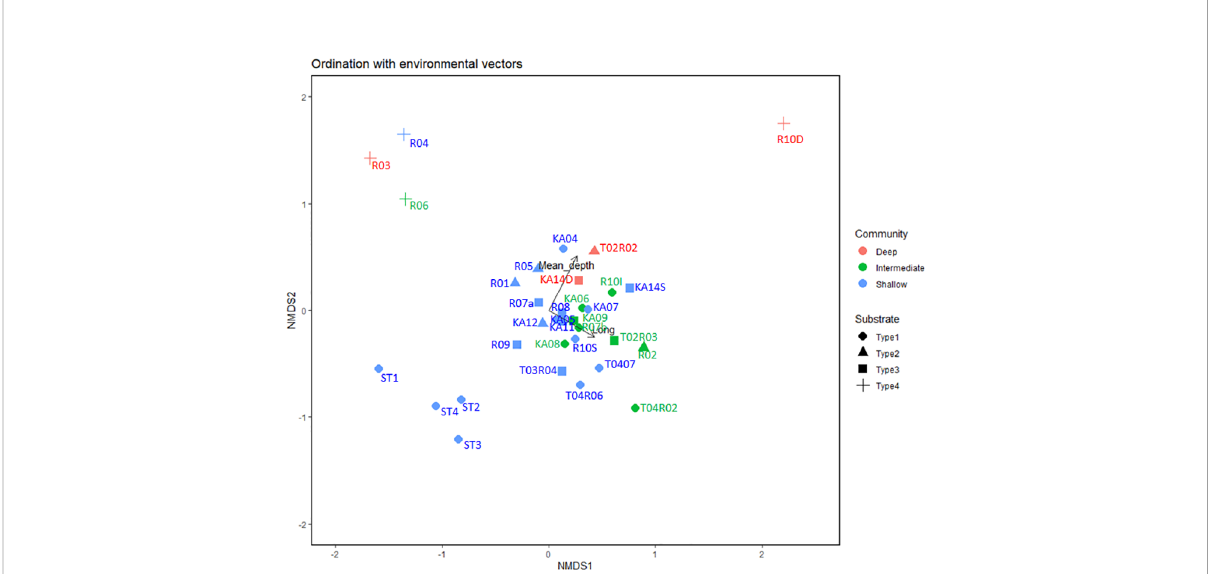
FIGURE 4 NMDS ordination plot based on presence – absence data of sublittoral benthic assemblages in the KNR waters (only ROV stations). Category of substrate types and vectors as longitude and mean depth were included in the ordination due to their signi fi cant correlation. Length of vectors are proportional to importance of each predictor variable (Stress = 0.141).